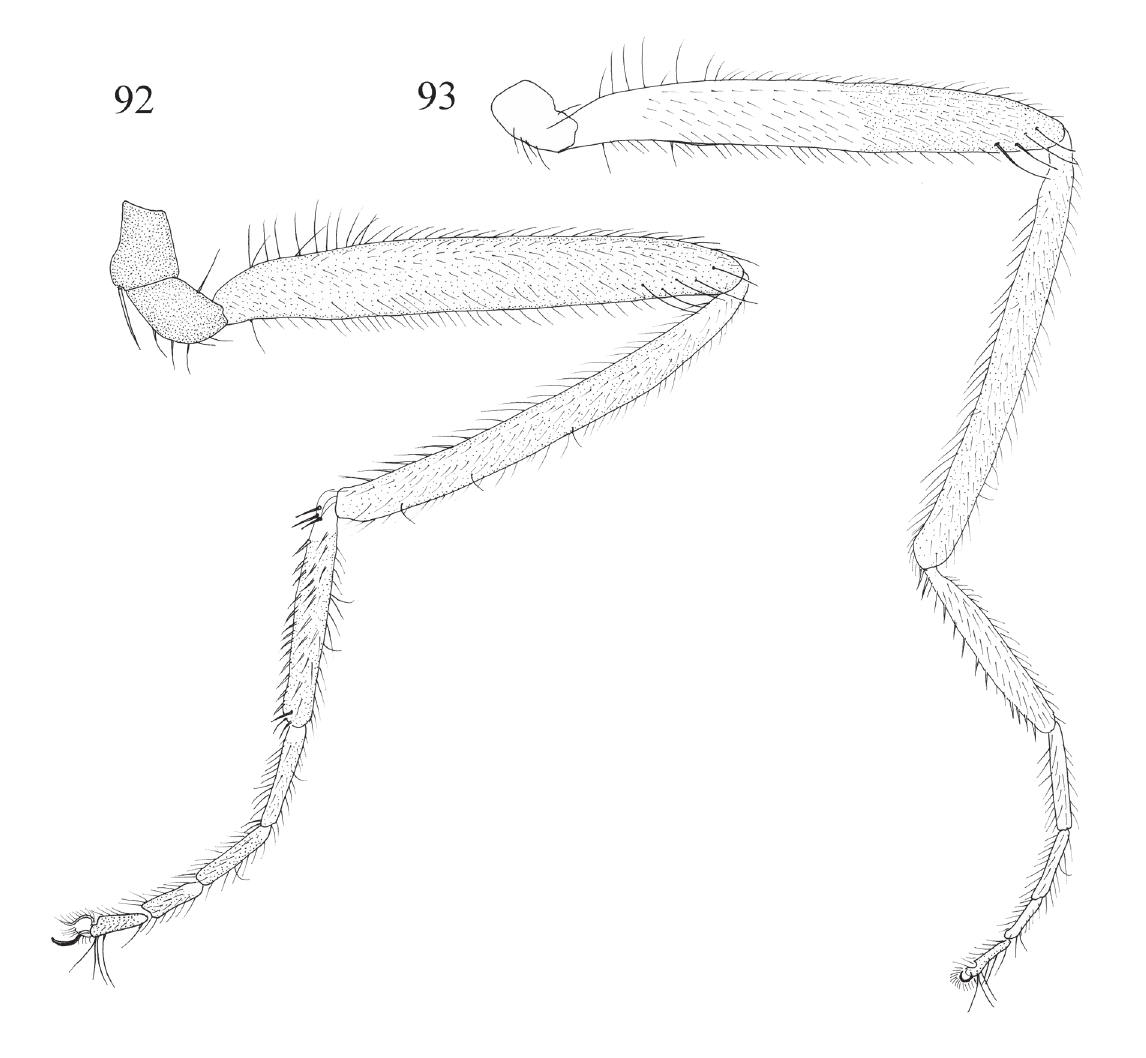
Figs 92-93. Hind leg of Drapetis , ♂, anterior view. 92 . D. pantai sp. nov. 93 . D. bakau sp.